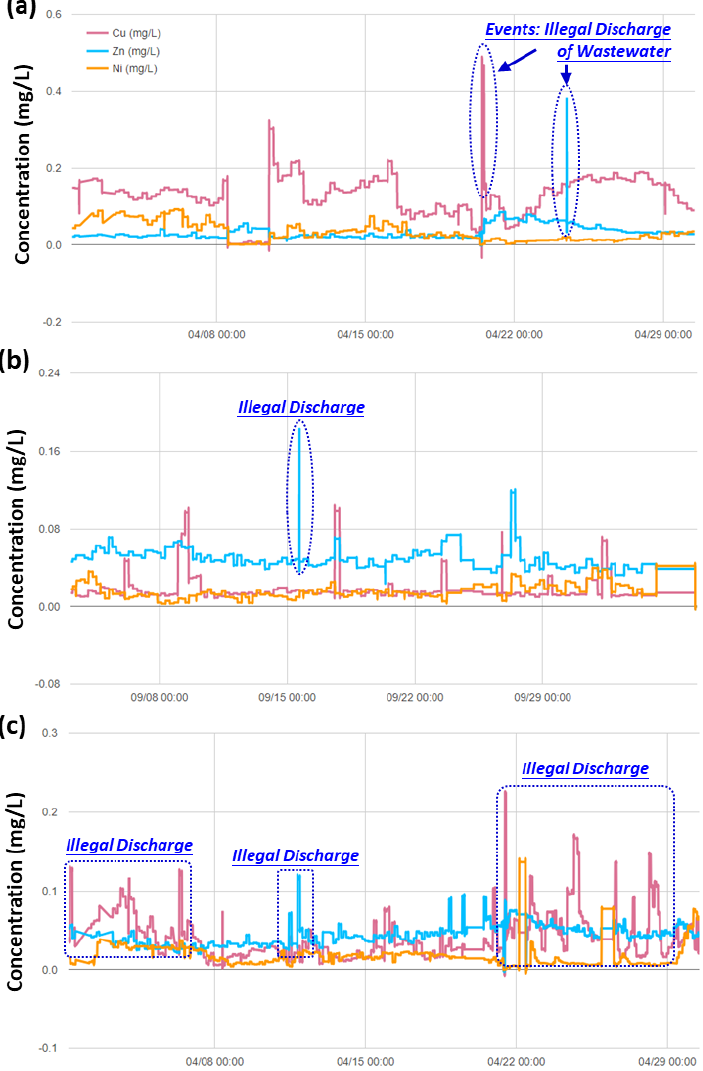
Figure 7. Patterns and trends of heavy metals monitoring ( a ) at the Taoyuan Station A on April 2019, ( b ) at the Taoyuan Station B on September 2018, and ( c ) at the Taoyuan Station C on April 2019.